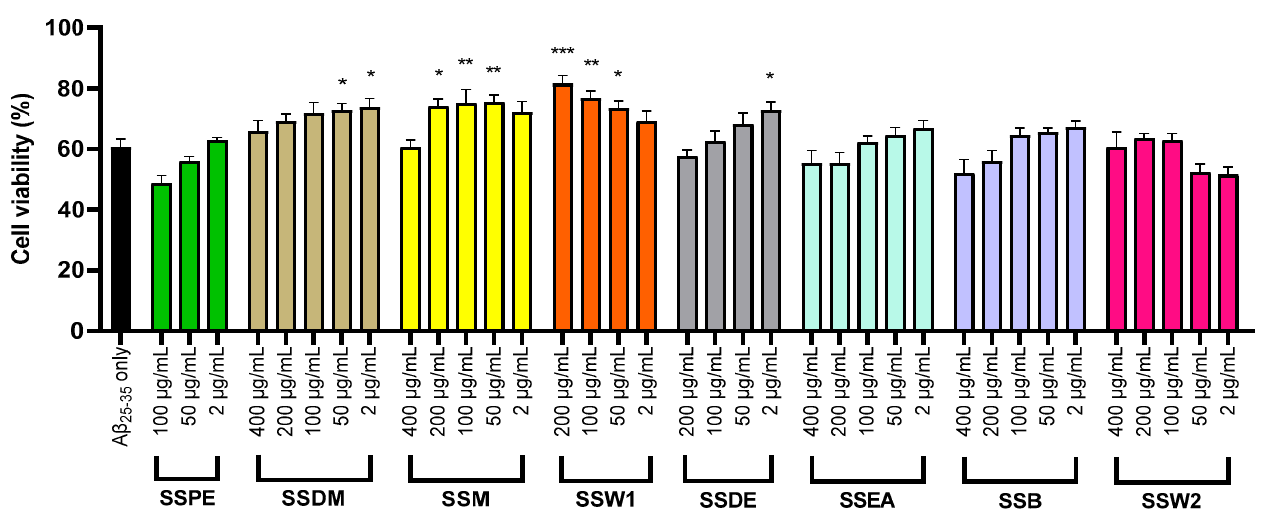
Figure 4. Determination of the neuroprotective capacity of the different SS mixtures against amyloid-beta-induced toxicity in SH-SY5Y. Error bars show the SEM values of five separate experiments. Note: * ( p < 0.05), ** ( p < 0.01), and *** ( p < 0.001) when compared to cells treated solely with 30 µM A β 25–35 .